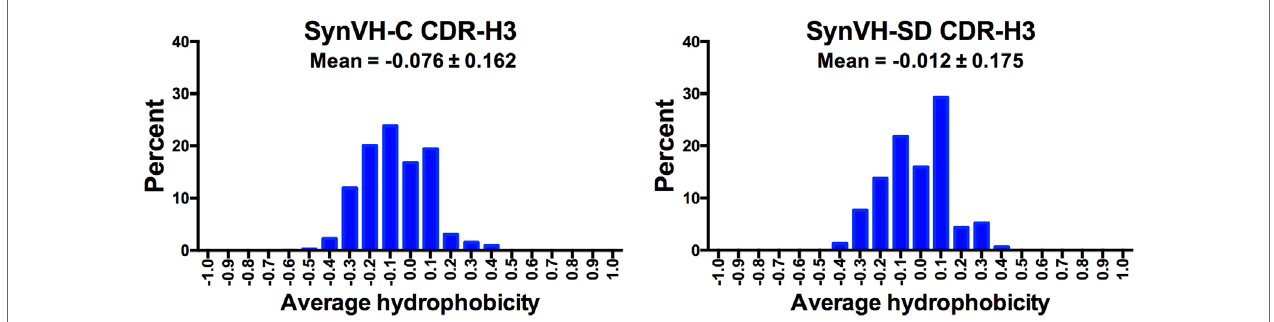
FigUre 6 | Hydrophobicity of CDR-H3 is similar in SynVH-C and SynVH-SD. Average hydrophobicity based on the normalized Kyte–Doolittle scale (35, 36) of CDR- H3s of lengths 12–15 residues (IMGT positions 105–117) were calculated for the top 1,000 sequences from each bird. The frequencies of each hydrophobicity value (grouped into increments of 0.1) are shown in the graphs.